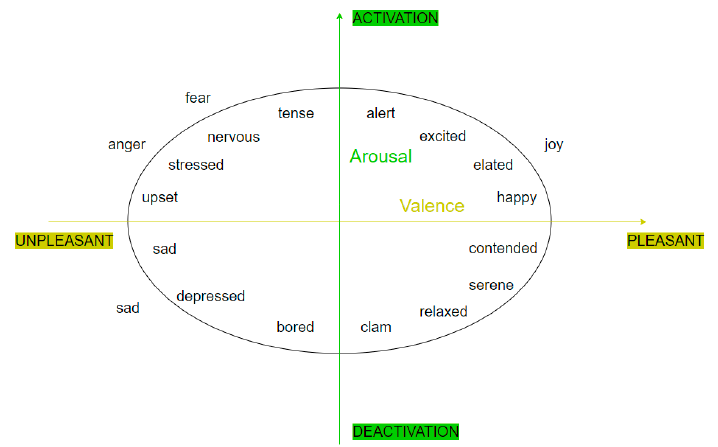
Figure 3. Emotional valence-arousal model.